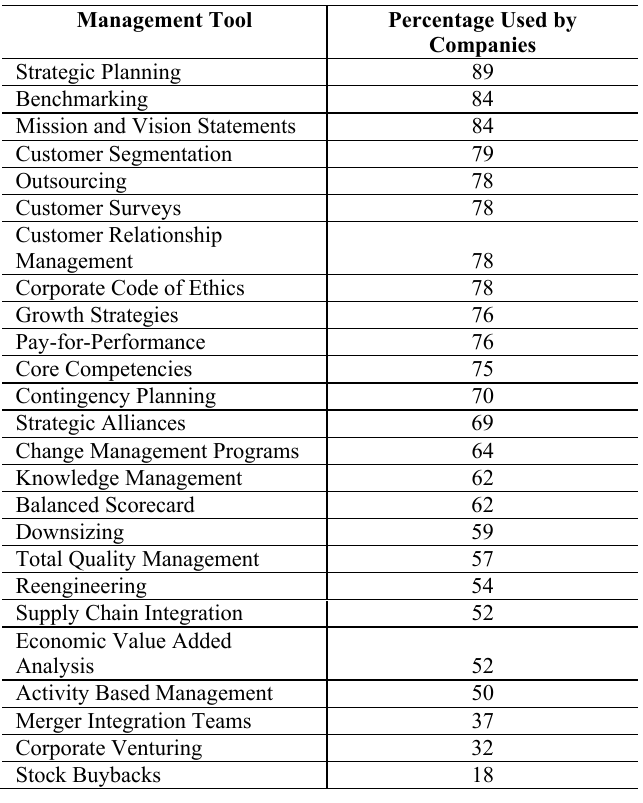
Table 1: Management tools used in 2002 (Rigby, 2003) Management